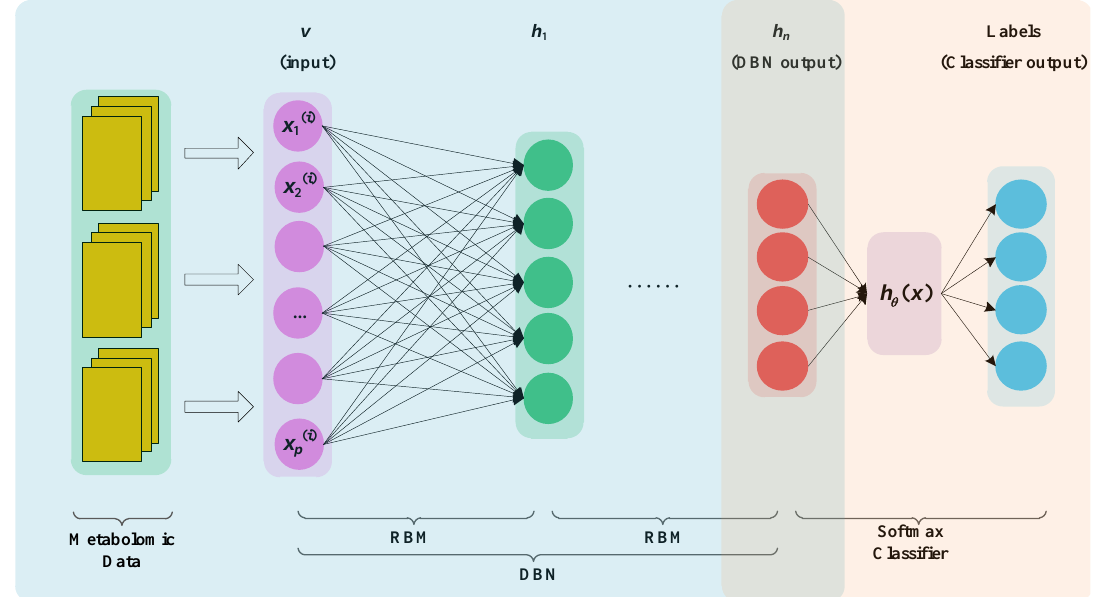
Figure 4. MDBN model. The yellow rectangles represent the metabolomics data. After preprocessing, the data are fed to DBN. The purple circles represent input layer. The green circles represent output layer of the first RBM. The red circles represent the output of DBN. The blue circles represent the output layer of Softmax classifier.